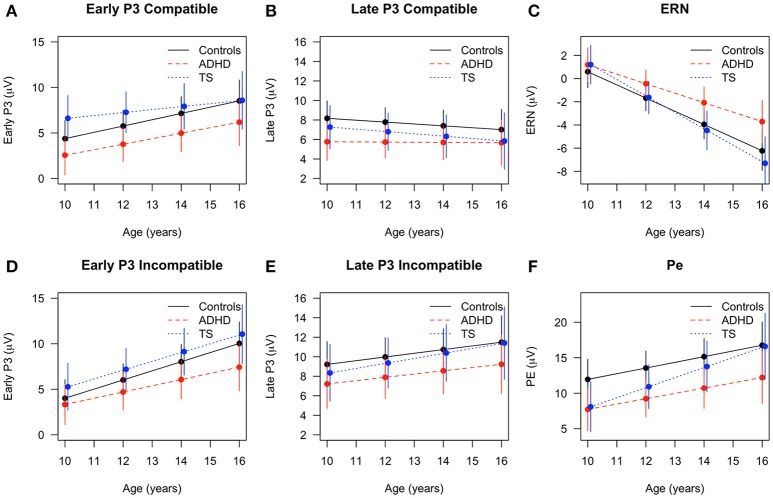
Developmental trajectories across age in event-related components with fitted values and 95% confidence intervals for children with TS (blue), children with ADHD (red), and control children (black). Early P3 in (A) compatible and (D) incompatible trials, late P3 in (B) compatible and (E) incompatible trials, (C) error-related negativity (ERN) in erroneous trials, (F) Pe in erroneous trials.